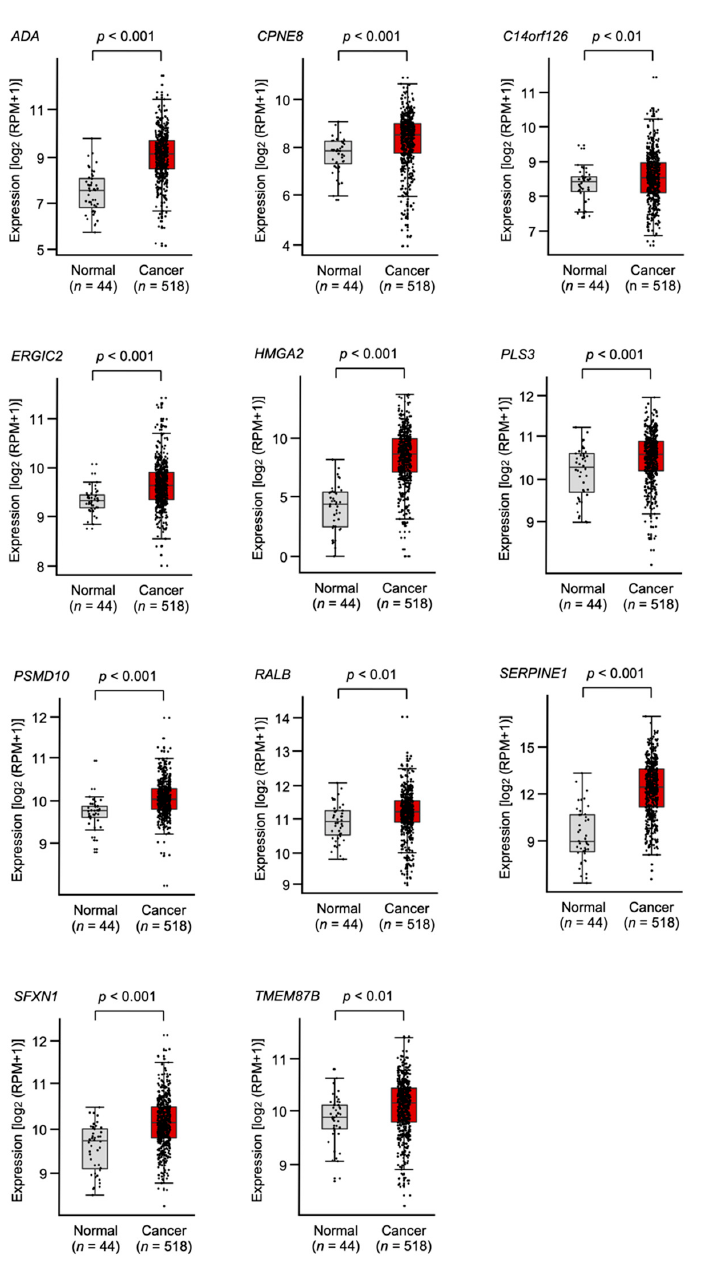
Figure 3. HNSCC tissue expression of 11 target genes of miR-30e-3p using TCGA-HNSC data. The expression levels of 11 genes ( ADA , CPNE8 , C14orf126 , ERGIC2 , HMGA2 , PLS3 , PSMD10 , RALB , SERPINE1 , SFXN1 , and TMEM87B ) were analyzed using the TCGA-HNSC database. A total of 518 HNSCC tissues and 44 normal epithelial tissues were evaluated.